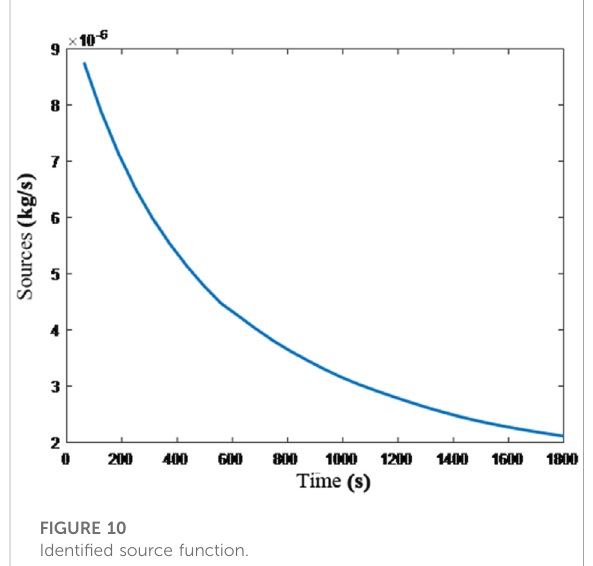
Rate of change of the source